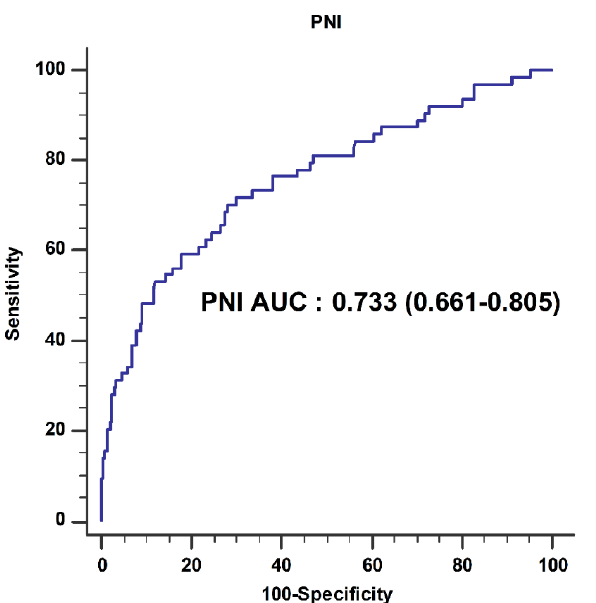
Figure 1. Receiver operating characteristic (ROC) curve analysis of the prognostic nutritional index (PNI) for predicting intraoperative transfusion.